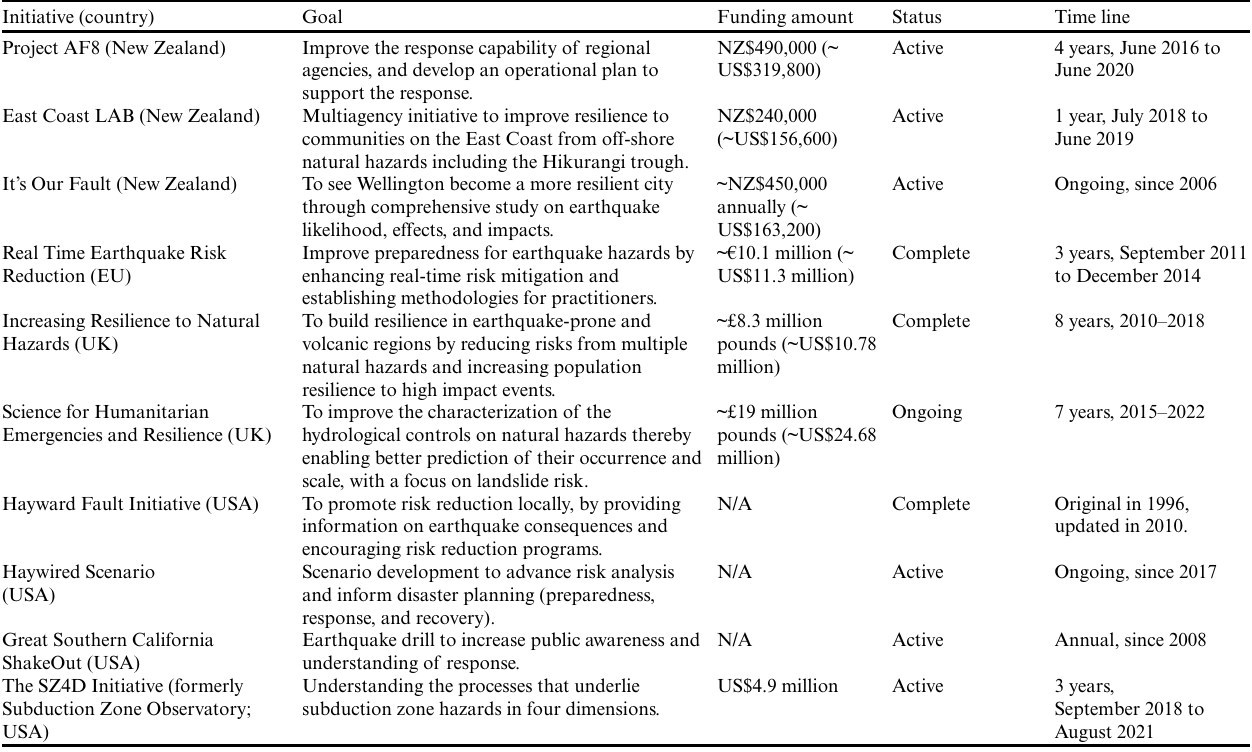
Table 1 . Examples of large multidisciplinary disaster resilience initiatives since 2008, involving disaster risk management decision makers, scientists, and public